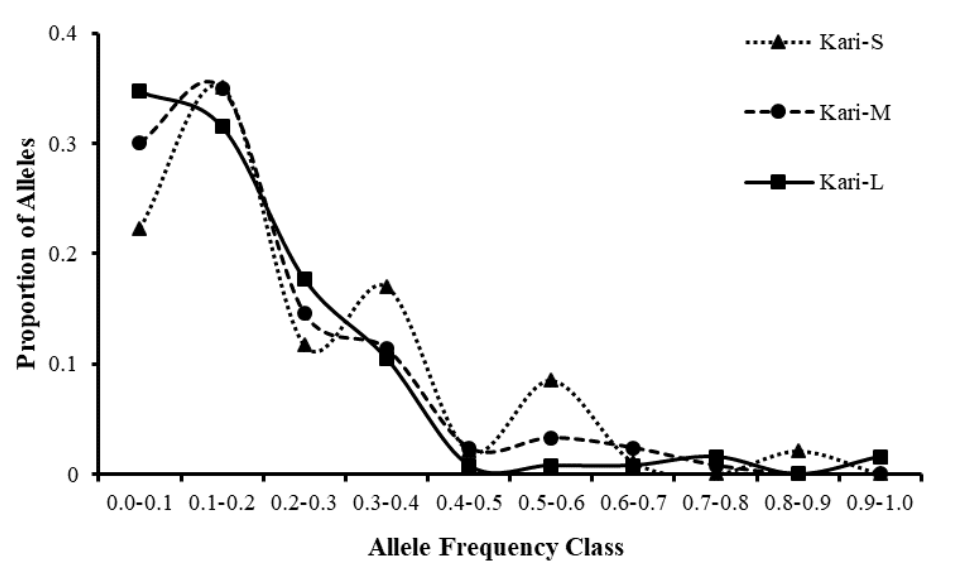
Figure 6. Allele frequency distribution graph of the three Kari subtypes. A mode shift can be seen in Kari–S subtype, while Kari–M and Kari–L subtypes followed a normal L–shape graph.